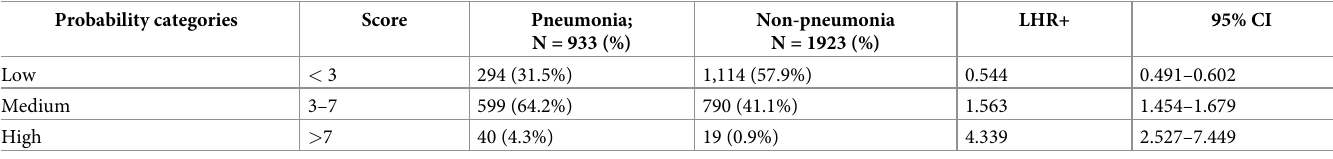
Table 4. Probability categories and the predictive